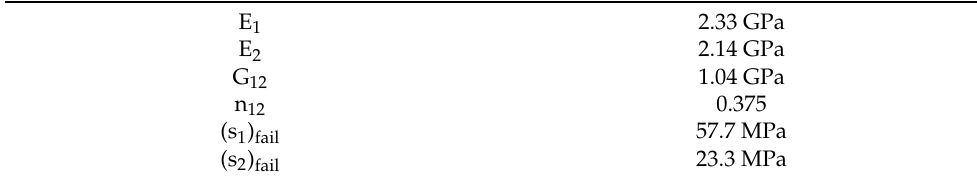
Table 3. Properties of PLA specimens.